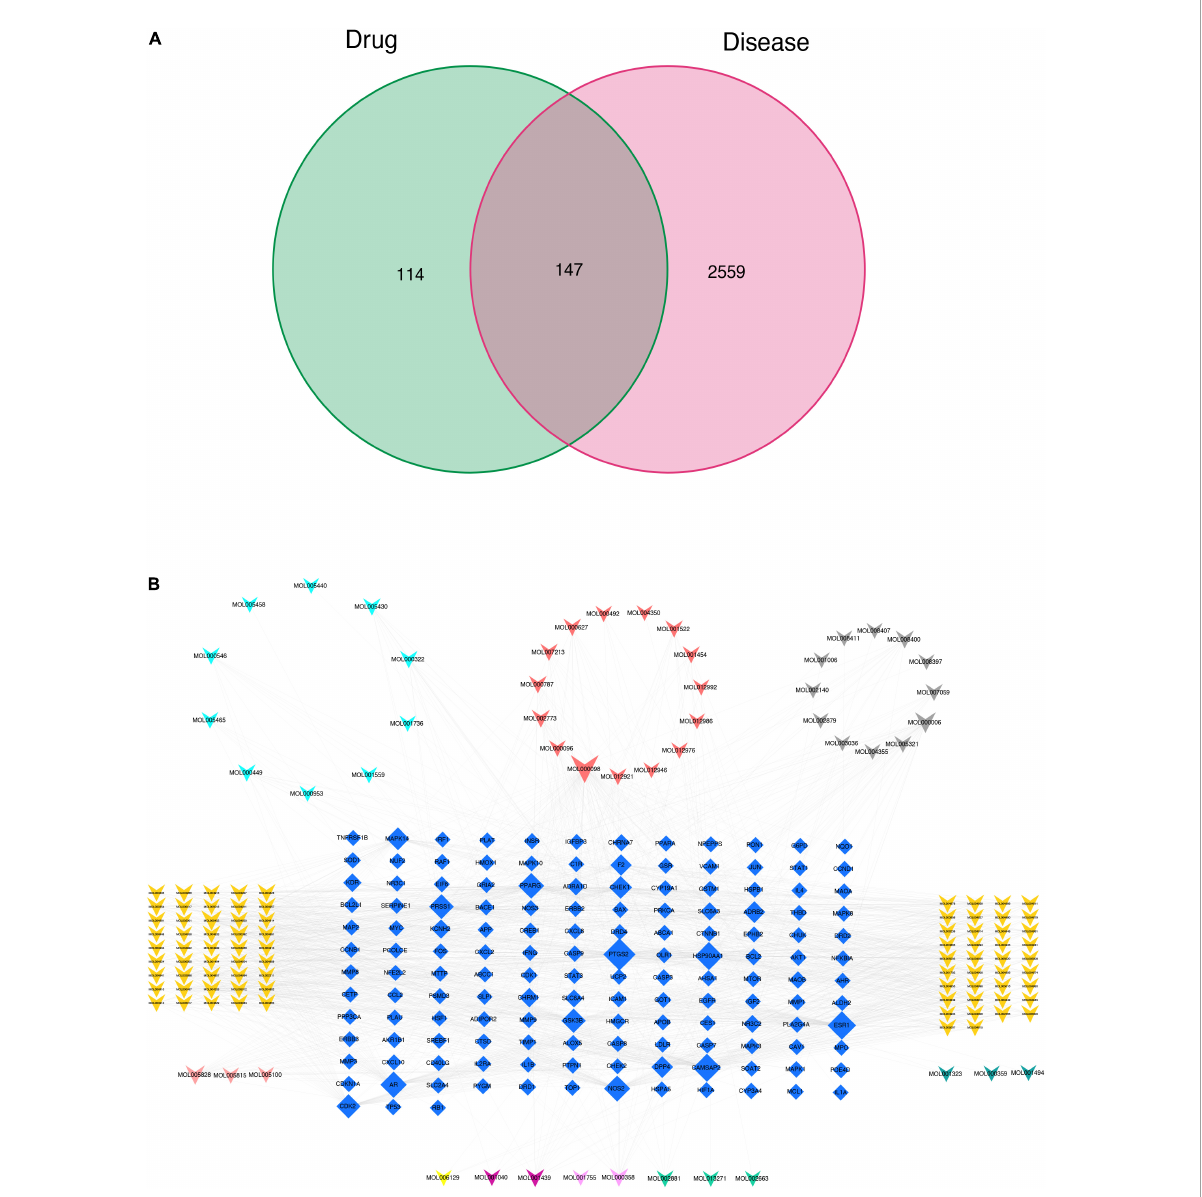
FIGURE2 Construction of the target genes set (A) and compound-target network (B) . Blue quadrilateral nodes indicate targets, while differentially colored V nodes denote compounds. The dark yellow, light purple, light red, light blue, dark green, gray, dark red, dark purple, light yellow, and light green V nodes represent active compounds of Glycyrrhiza uralensis Fisch., Amomum villosum Lour., Citrus reticulata Blanco., Dioscorea opposite Thunb., Coix lacryma-jobi L.var.ma-yuen (Roman.) Stapf., Codonopsis pilosula (Franch.) Nannf., Ziziphus jujuba Mill., Typha